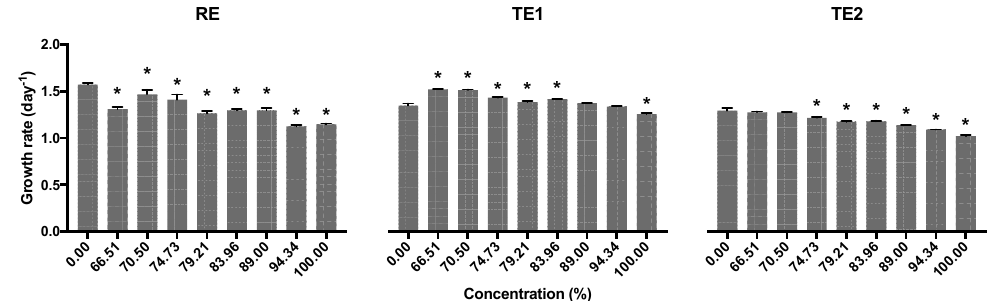
Figure 1. Average growth rate (day −1 ) of R. subcapitata exposed to different dilutions of the effluent. Error bars represent the standard deviation of the mean (n = 3); asterisks indicate statistically significant differences from the control (Dunnett’s test p < 0.05).